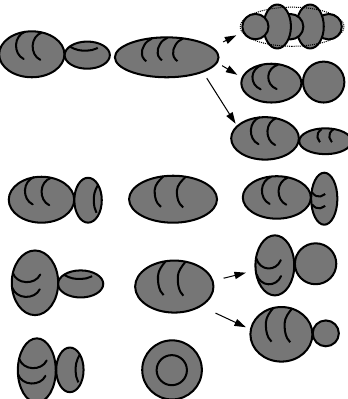
Fig. 1. Excited states in 36 Ar, observed as resonances in the 12 C + 24 Mg (open circles) and 16 O + 20 Ne (full circles) reactions. The SD band observed in 36 Ar and the ground-state band are also included. The shapes are from Nilsson-calculations.